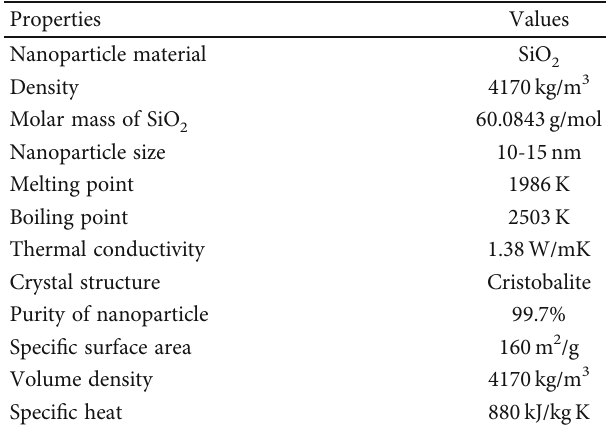
Table 2: Speci fi cation of the